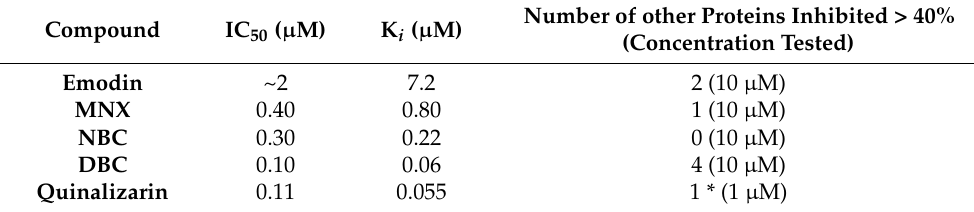
Table 2. Comparison of IC 50 and K i values for emodin and its improved derivatives [61,62,93]. Emodin was tested at 10 µ M on a panel of 33 kinases; CK2 was only inhibited by 49% [60]. MNX, NBC and DBC were tested at 10 µ M against a panel of 33 kinases [62]. Quinalizarin was tested at 1 µ M on a panel of 75 kinases